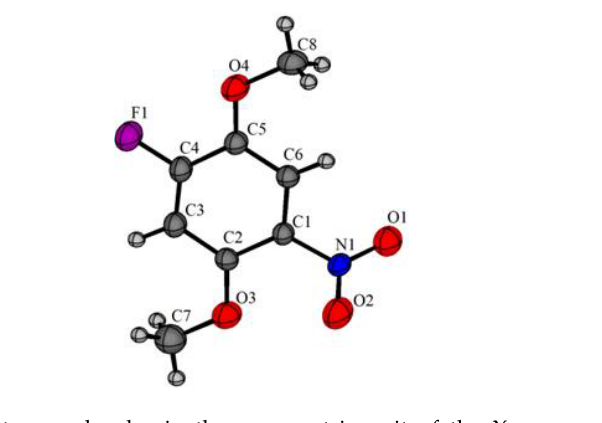
Figure 1 . One of the two molecules in the asymmetric unit of the X-ray crystal structure of 1-fluoro-2,5-dimethoxy-4-nitrobenzene ( 5 ), 40% ellipsoids.